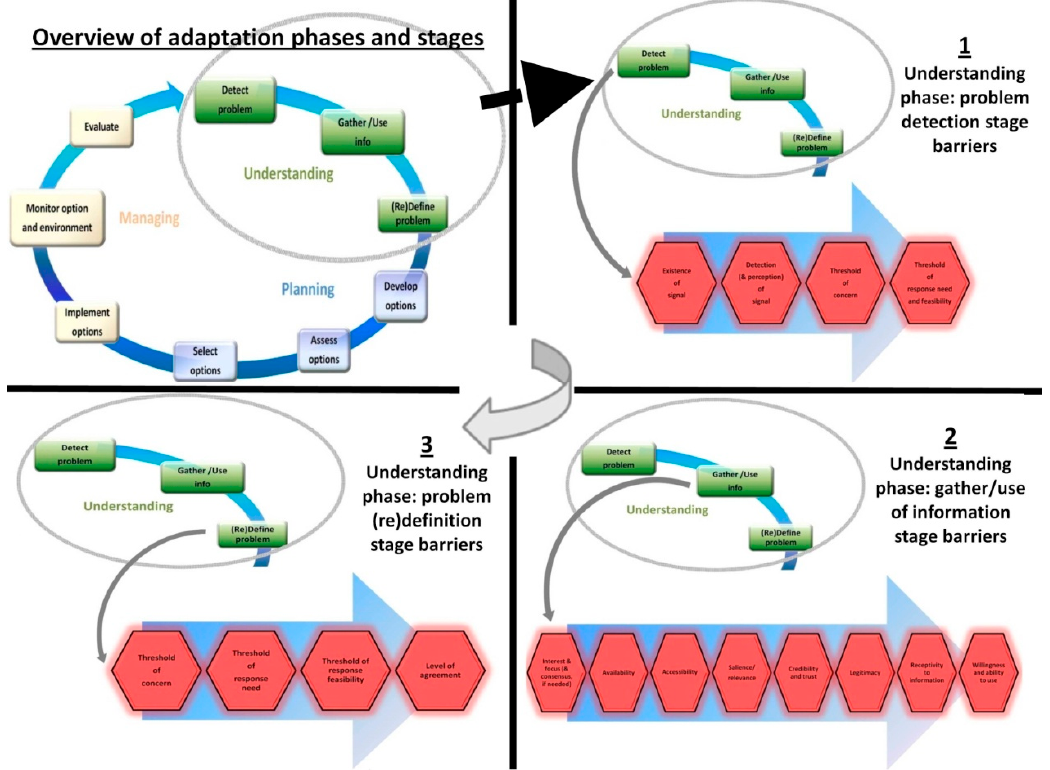
Figure 3. Adaptation phases and stages, with a focus on barriers to understanding (after [26]).